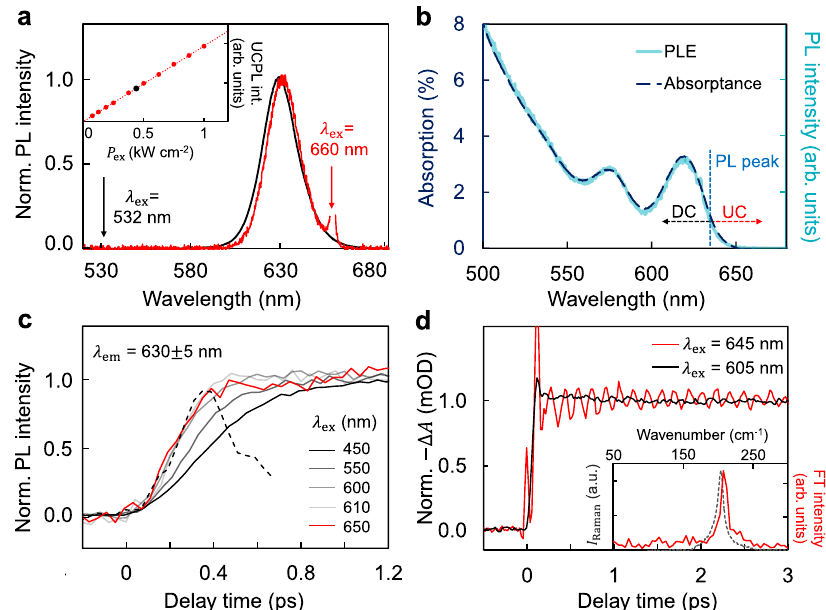
Fig. 1 Spectral properties of ensemble QDs. a Normalized UCPL (red) and DCPL (black) spectra excited at 660 and 532 nm respectively. λ ex denotes excitation wavelength. Inset: excitation power density ( P ex ) dependent UCPL intensity. The red dashed line represents a linear fi tting. The power density used in UCPL spectrum measurements is marked with a black dot. b Percentage absorption spectrum (dashed deep blue line) and photoluminescence excitation (PLE) spectrum (solid cyan line) monitored at the photoluminescence peak position (PL peak, 630 nm). ‘ DC ’ and ‘ UC ’ denote down-conversion and up-conversion excitation wavelength ranges respectively. c Normalized femtosecond-resolved photoluminescence spectra monitored at 630 nm under different excitation wavelengths. The black dashed line is the instrument response function. d Normalized femtosecond-resolved absorption spectra monitored at the fi rst absorption peak (620 nm) under up-conversion (red) and down-conversion (black) excitations. Inset: the Fourier transform of the red curve in the main fi gure (red solid line) along with the resonant Raman spectrum of CdSe QDs (grey dashed line).